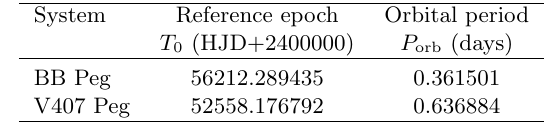
Table 3. Light elements used in the computation of the orbital